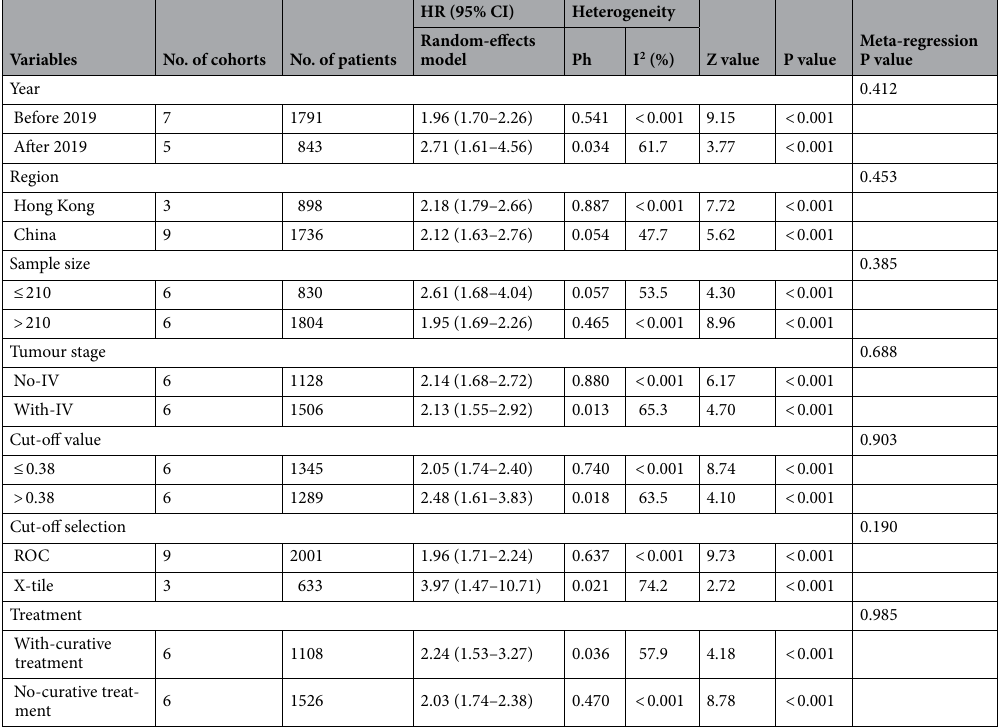
Table 2. Results of subgroup analysis and meta-regression analysis for OS. ROC the receiver operating characteristic, HR hazard ratio, 95% CI 95% confidence interval, Ph P-value of Q test for heterogeneity test.